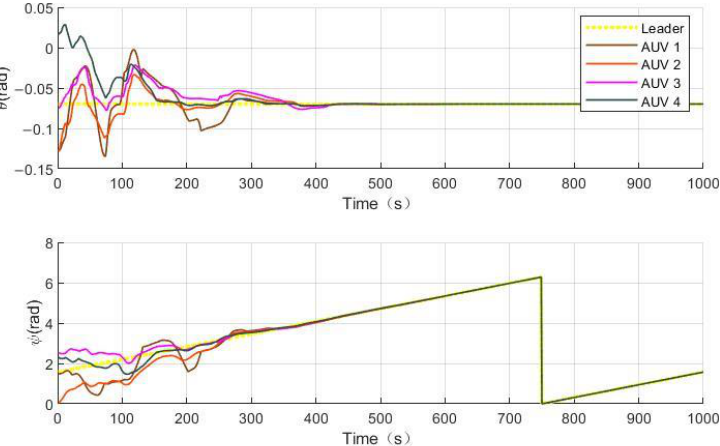
Figure 17. Position status of the AUV formation when using the controller in [13].